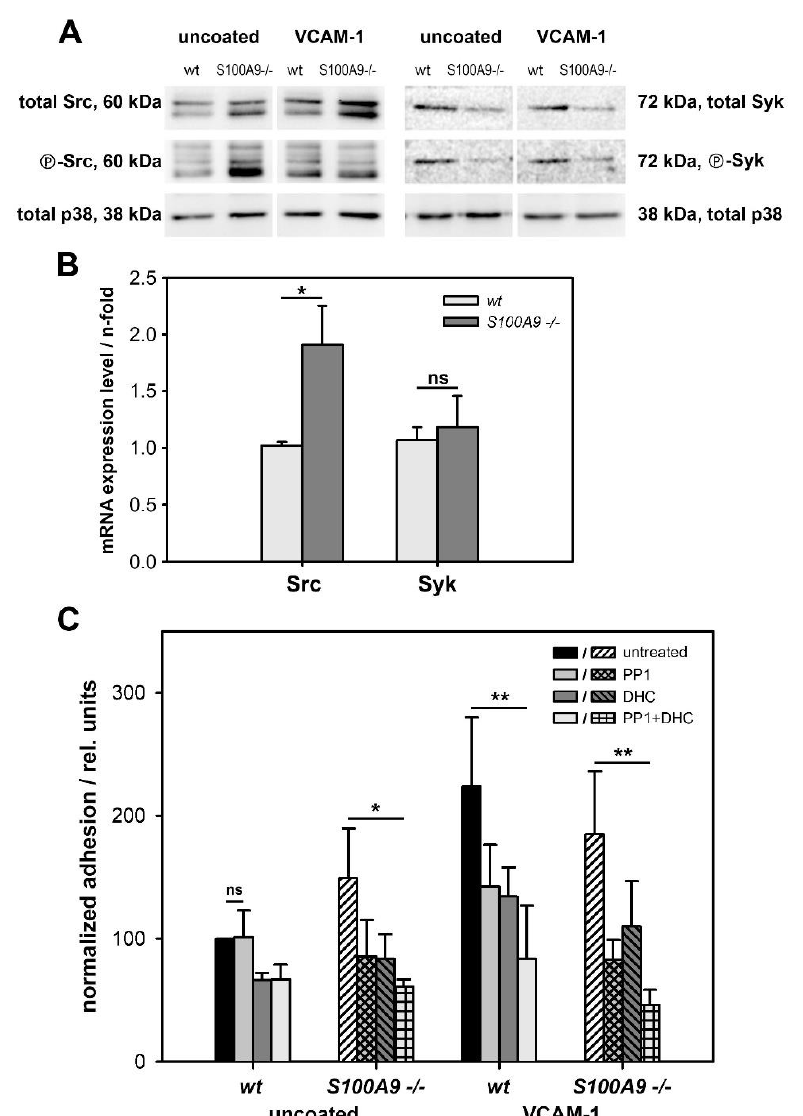
Figure 7. Differential expression and regulation of tyrosine kinases Src and Syk in S100A9 -/- BMCs affected cell adhesion. ( A ) Western blot analysis of total Src and Syk expression as well as Src and Syk activation in the presence or absence of the integrin ligand VCAM-1 after 1 h of adhesion. S100A9 -/- BMCs showed a significantly higher amount of total Src in comparison to the wildtype (wt) cells, while the opposite was found for the Syk expression levels. In the absence of a specific integrin ligand, the wildtype cells showed less Src-416 phosphorylation compared to the S100A9-deficient cells, but in the presence of VCAM-1, it matched the phosphorylation level of S100A9 -/- BMCs. Phosphorylation of Syk was higher in the wildtype cells and independent of VCAM-1. ( B ) RT-PCR analyses of Src and Syk mRNA content confirmed the observed difference in total Src expression, but Syk was found to be equally expressed at the mRNA level. Data were normalized to GAPDH as the housekeeping gene, n = 4; mean ± SD; * p < 0.05, ns = not significant. ( C ) Adhesion assay (1 h) of the wildtype and S100A9 -/- BMCs in the presence (30 min preincubation) or absence of the specific Src-inhibitor PP1 (10 µM) and/or the specific Syk-inhibitor DHC (2 µM). In the absence of VCAM-1, the addition of either inhibitor led to a decrease in adhesion in S100A9 -/- cells, but the wildtype cells were only affected by Syk blocking. In the presence of VCAM-1, however, both genotypes were equally affected by the addition of the inhibitors and showed a significant decrease in cell adhesion. Data were normalized to untreated wildtype cells in the absence of VCAM-1 set to 100; n = 4; mean ± SD; ** p < 0.01; * p < 0.05, ns = not significant).